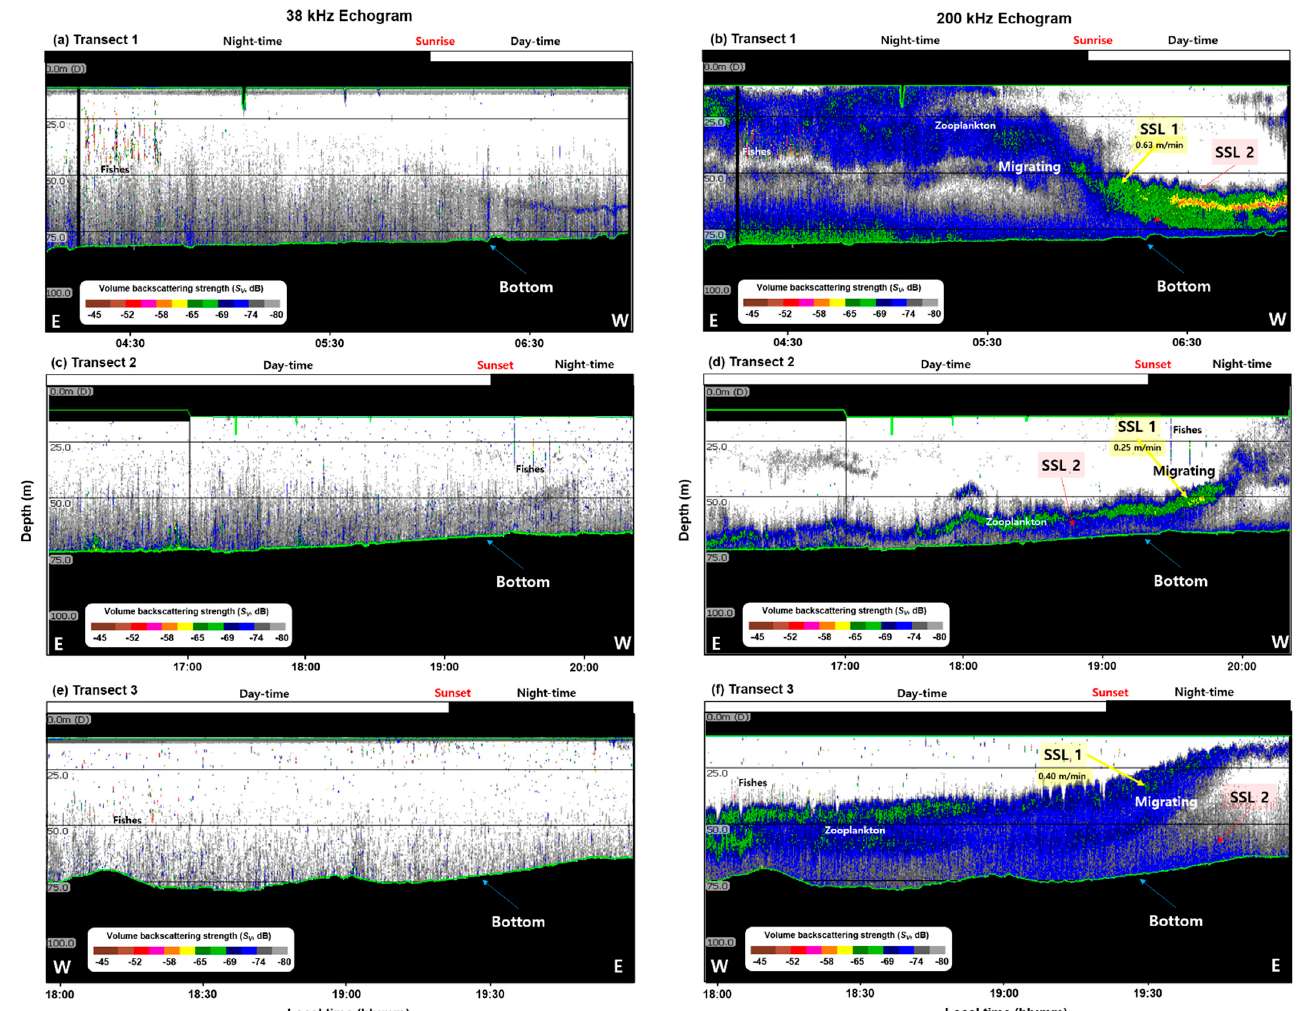
Figure 4. Vertical and spatial distributions of the 38 kHz ( a , c , e ) and 200 kHz ( b , d , f ) sample echograms for ( a , b ) Transect 1, ( c , d ) Transect 2, and ( e , f ) Transect 3. In the figure, E is east, W is west, black regions are bottom, and depth are divided by 25 m. Daytime and nighttime at the top are divided based on the on-site sunrise and sunset, and the green line is the measured and calculated regions considering the transducer depth, near-field effects, and bottom.